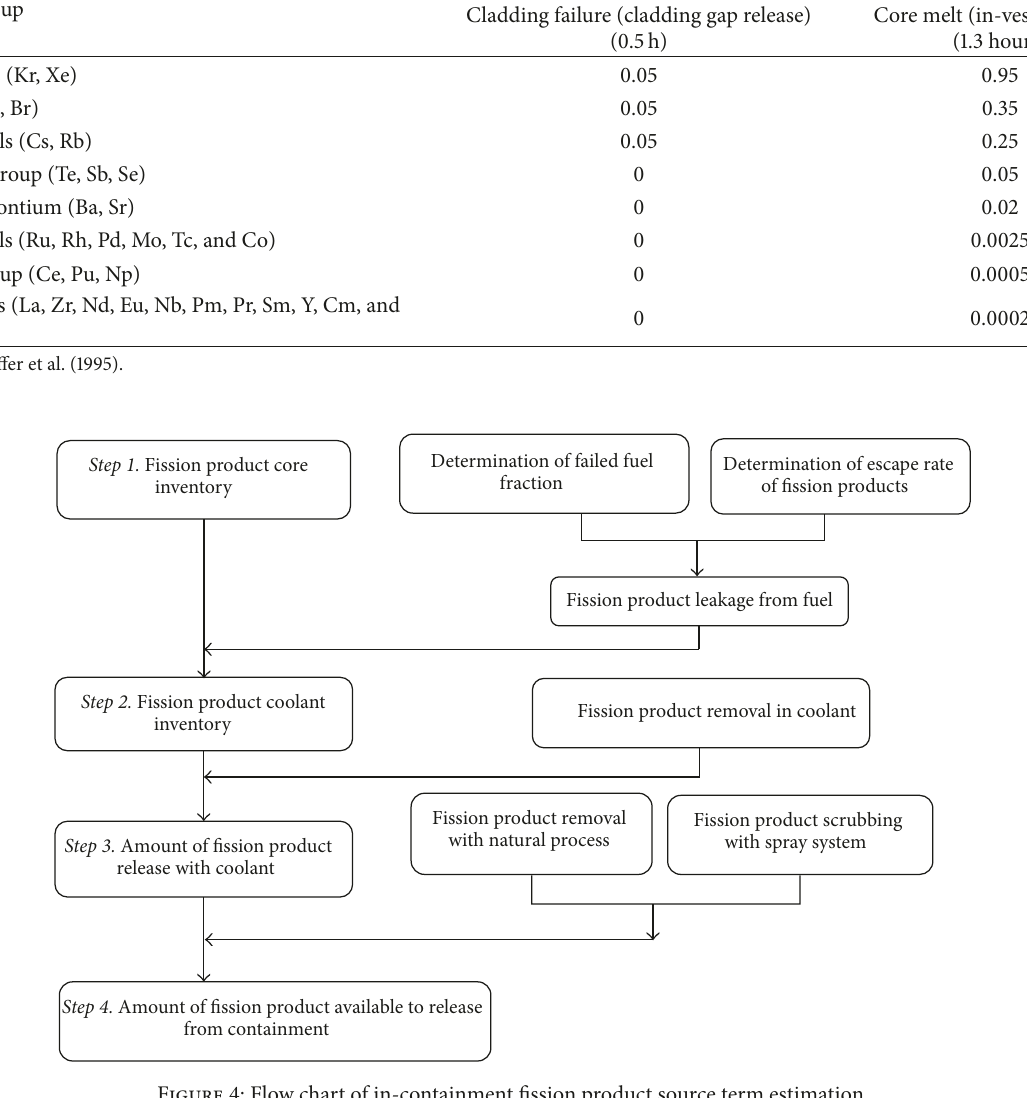
Figure 4: Flow chart of in-containment fission product source term